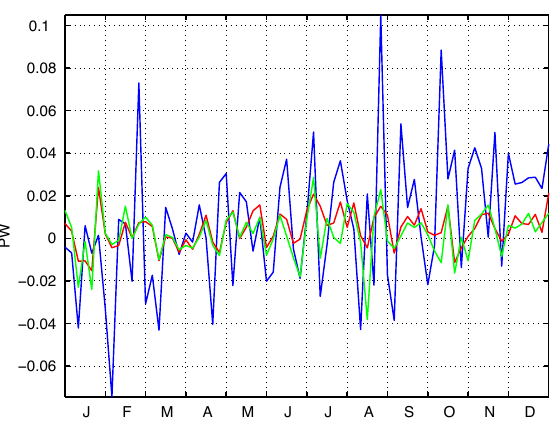
Fig. 8. Result for the equatorial region: estimate of the heat flux er- ror (in blue) resulting from ignoring the high frequency fluctuations compared with (red), the difference between rate of change of the model heat content and the fluxes calculated using the 5-day mean datasets, and (green) the same but using the instantaneous datasets to calculate Richardson numbers.